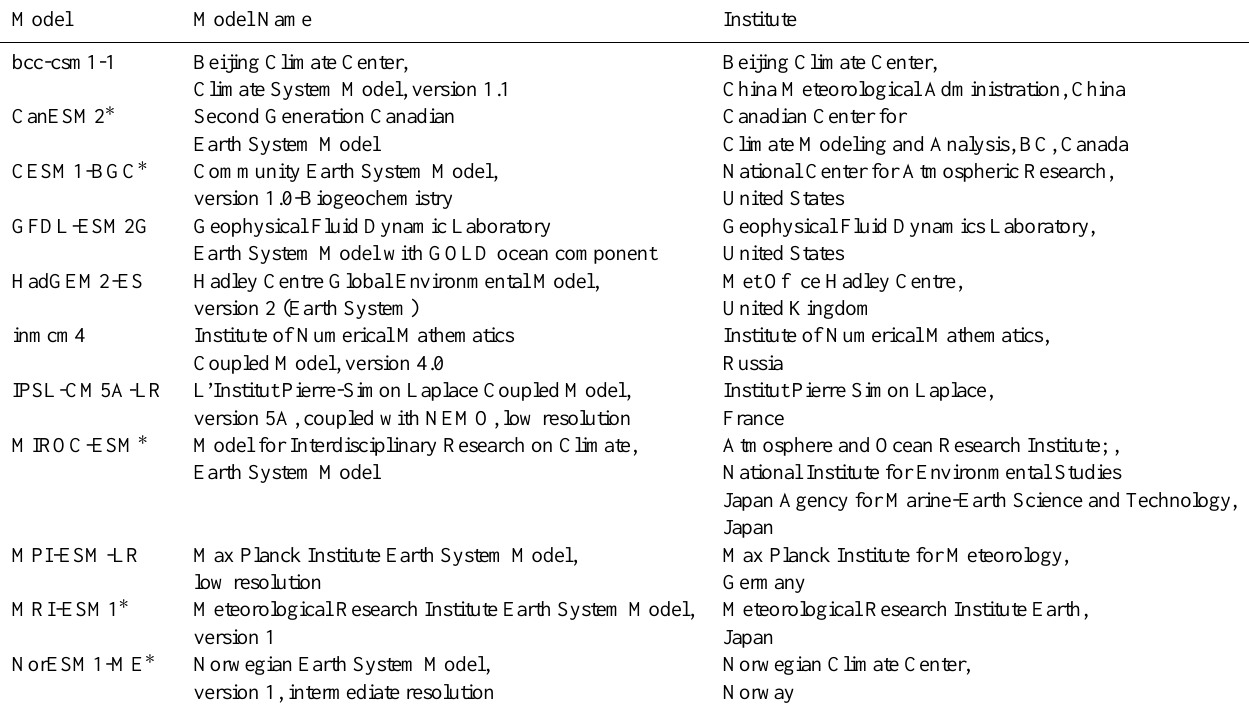
Table 3. CMIP5 ESM models used within this study. We use the same suite of models as found in Friedlingstein et al. (2014). Note, not all variables are reported for each model under all scenarios.